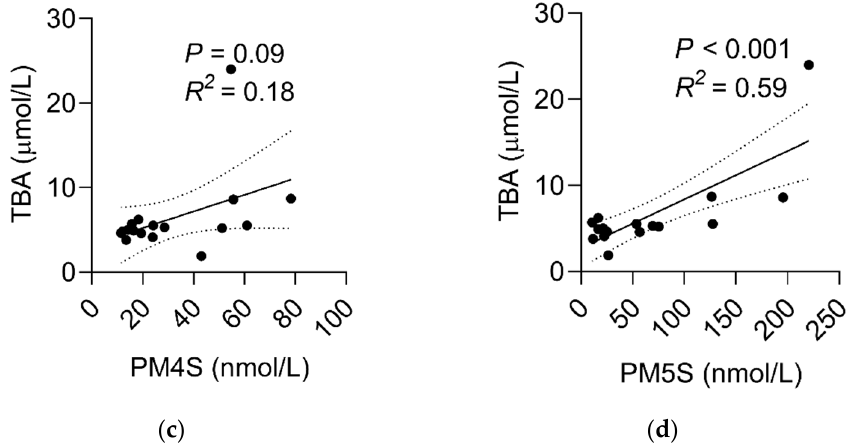
Figure 4. Comparison of fetal serum ( a ) progesterone, PM4S, and PM5S at G60, G90, and L0 (n = 5–6/group). The linear correlation of ( b ) progesterone, ( c ) PM4S, and ( d ) PM5S and fetal serum TBA (n = 17). Data are shown as means ± SE, * p < 0.05, ** p < 0.01, *** p < 0.001.